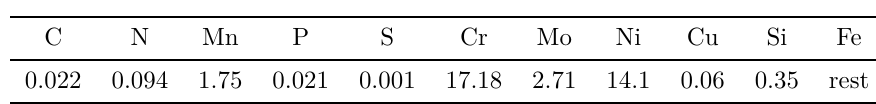
Table 1. Chemical composition of AISI 316L [wt %]